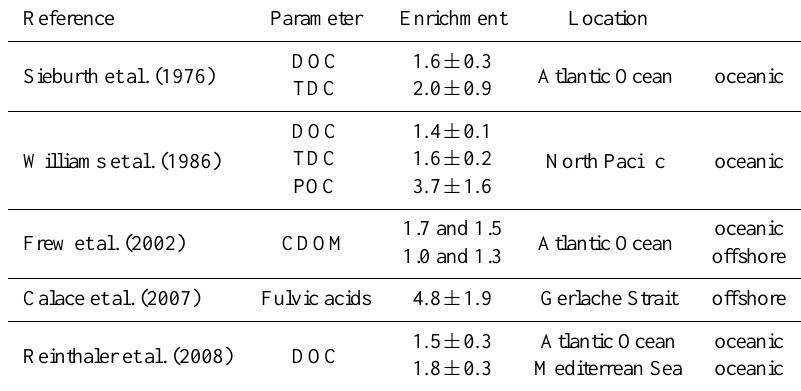
Table 6. Literature values of oceanic enrichments of organic material in the